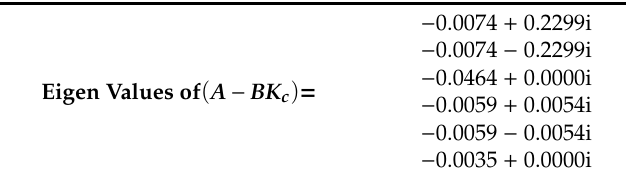
Table 5. Computed eigen values for stability analysis of the system.